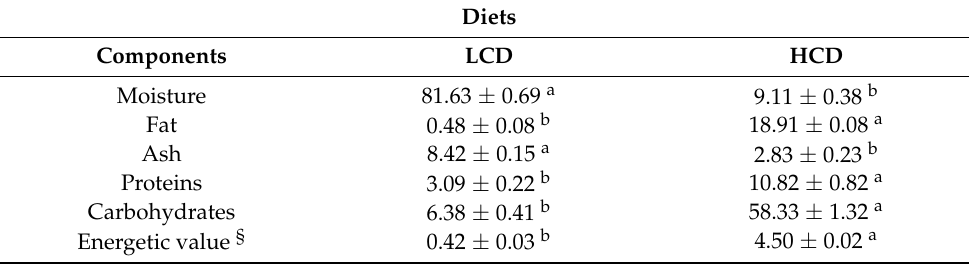
Table 1. Proximate chemical composition of LCD and of HCD.